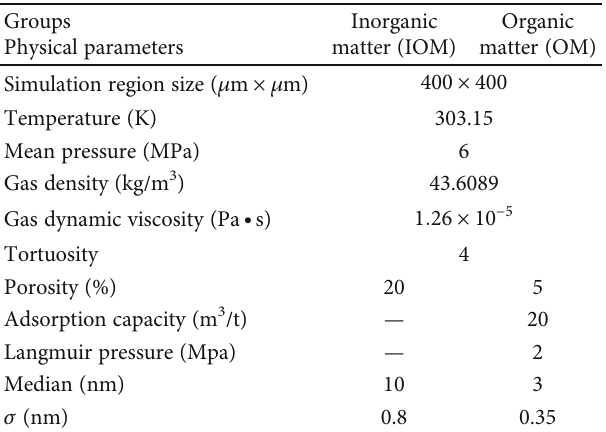
Figure 3: Random reconstruction images of coal matrix with di ff erent contents of OM and IOM. The volume fractions of OM and IOM are (a) ½ 0 : 48, 0 : 52 (cid:2) , (b) ½ 0 : 59, 0 : 41 (cid:2) , (c) ½ 0 : 62, 0 : 38 (cid:2) , (d) ½ 0 : 66, 0 : 34 (cid:2) , (e) ½ 0 : 72, 0 : 28 (cid:2) , (f) ½ 0 : 80, 0 : 20 (cid:2) , (g) ½ 0 : 85, 0 : 15 (cid:2) , and (h) ½ 0 : 93, 0 : 07 (cid:2) , respectively. Table 2: The physical parameters for simulation in three-component porous media.